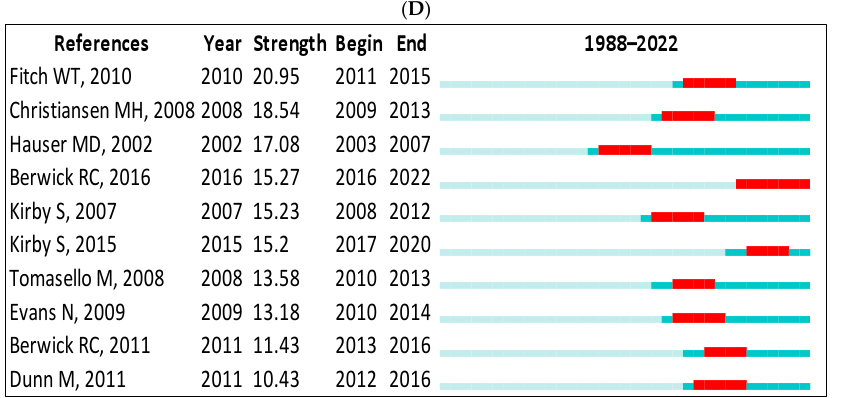
Figure 13. Top 10 cited authors and references with the strongest citation bursts. ( A ) (Scopus: cited